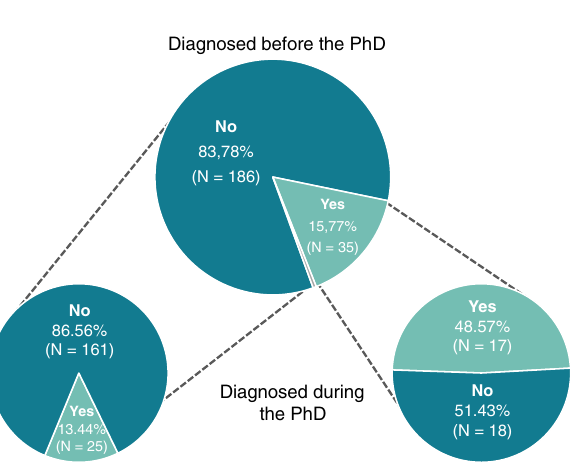
Figure 1. Diagnosis of a mental disorder. The top chart shows proportions of participants diagnosed with a mental disorder or not prior to the beginning of the PhD training (1 person preferred not to answer this question; in grey). Separately for those who answered yes and no, bottom charts show proportions of participants further diagnosed and not diagnosed with a mental disorder during their PhD training. Please note: One person preferred not to